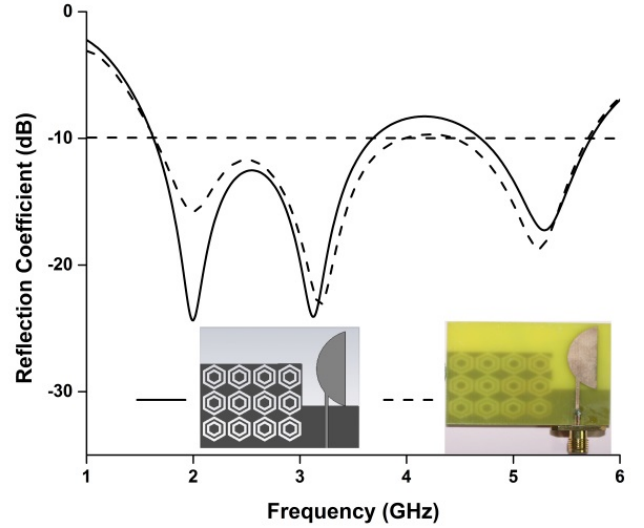
Figure 4. Proposed antenna fabricated prototype.